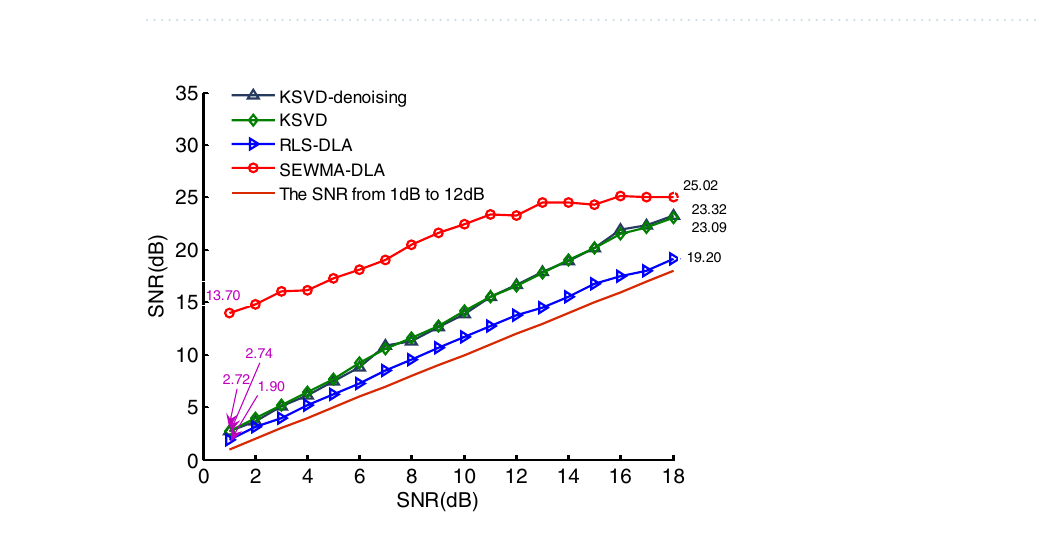
Figure 13. The denoising effect using the four